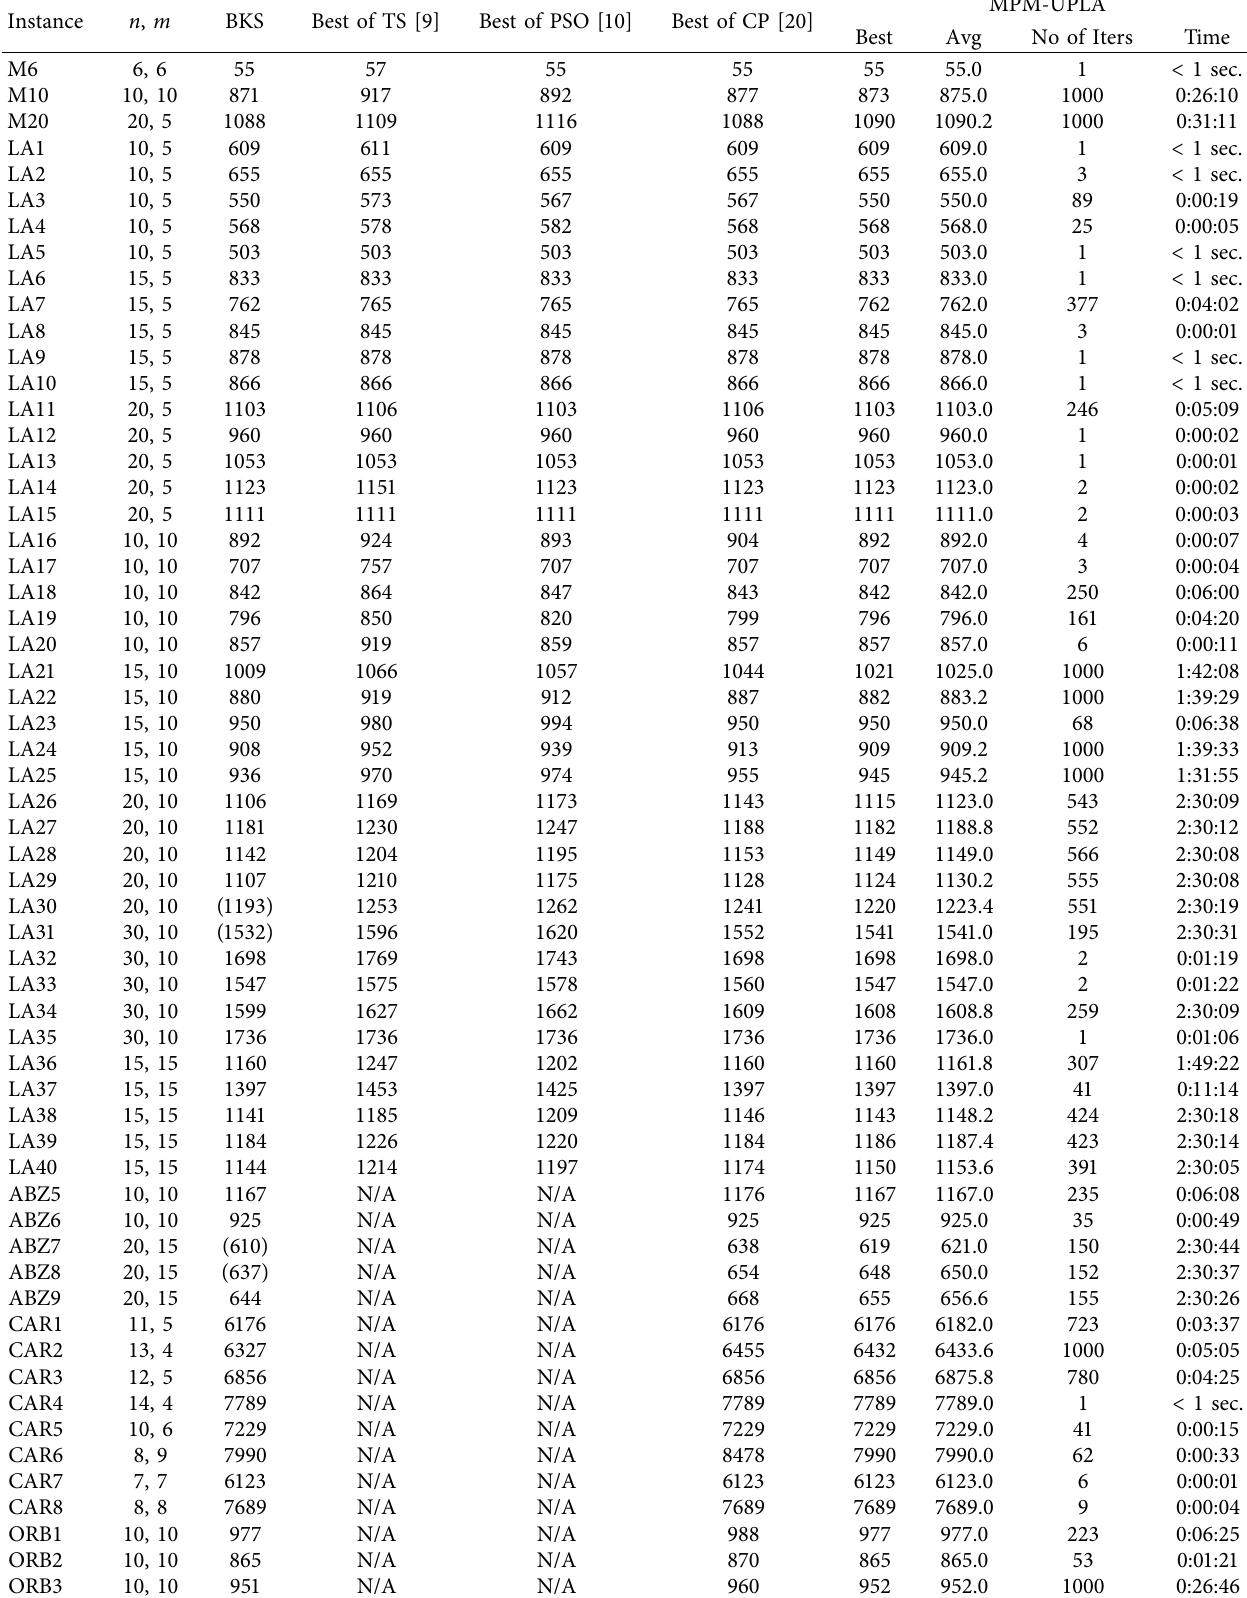
Table 1: Results on